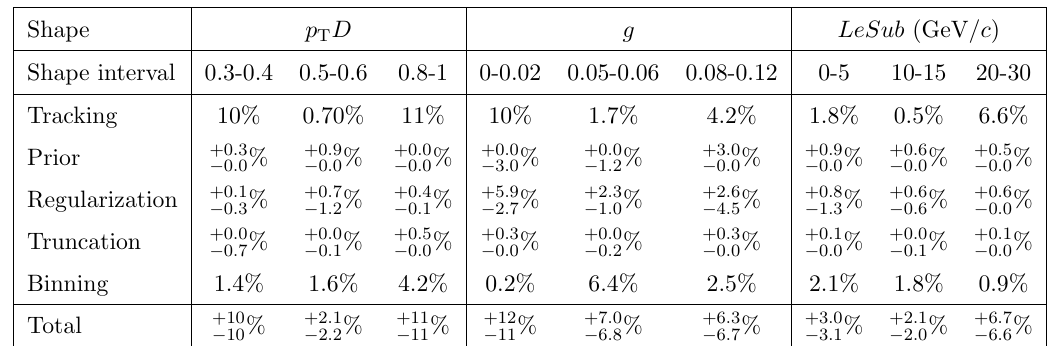
Table 1 . Relative systematic uncertainties on the measured jet shapes in pp collisions for three selected jet shape intervals in the jet p ch range of 40{60 GeV/ c . T ; jet Shape p T D g LeSub (GeV/ c ) Shape interval 0.3-0.4